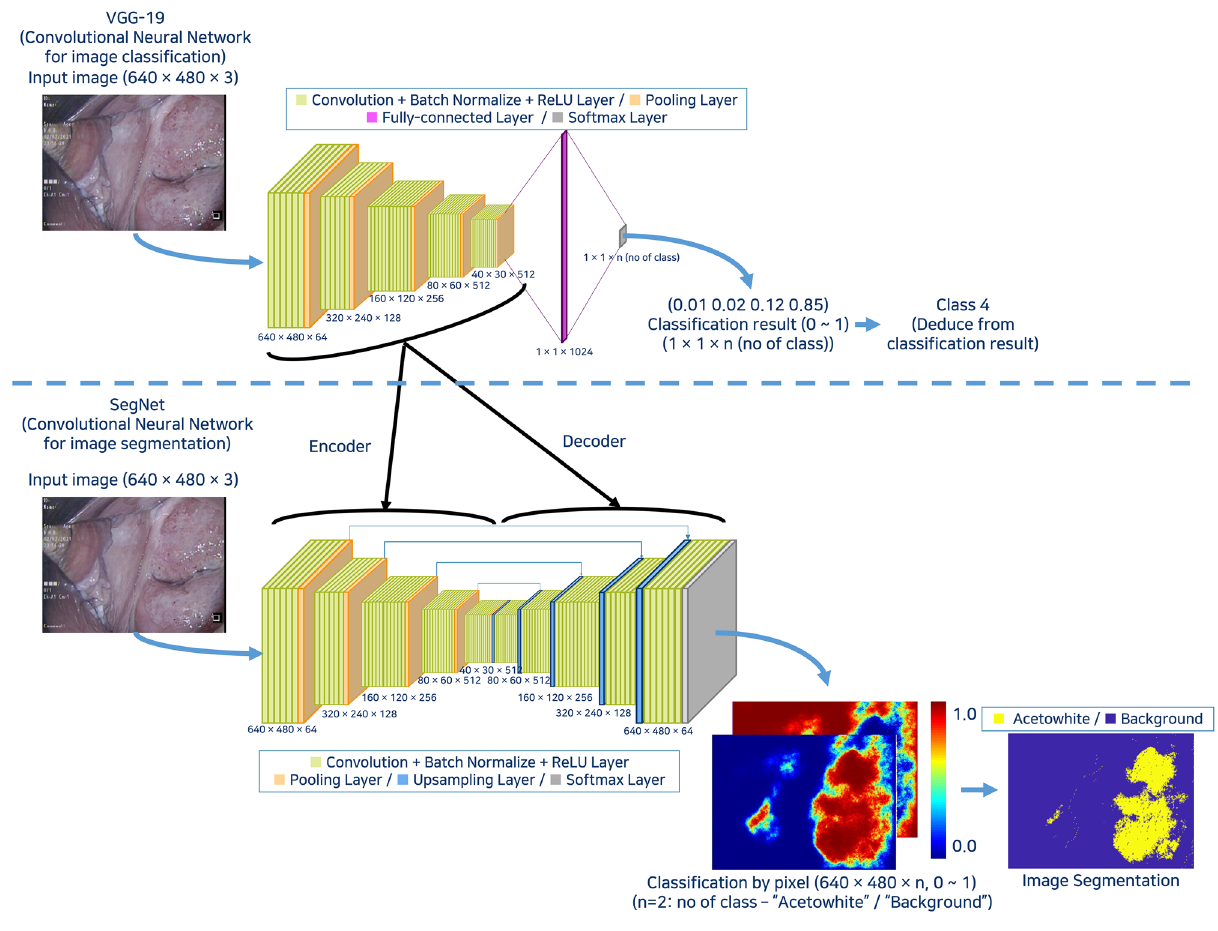
Figure 3. Architecture of VGG-19-based